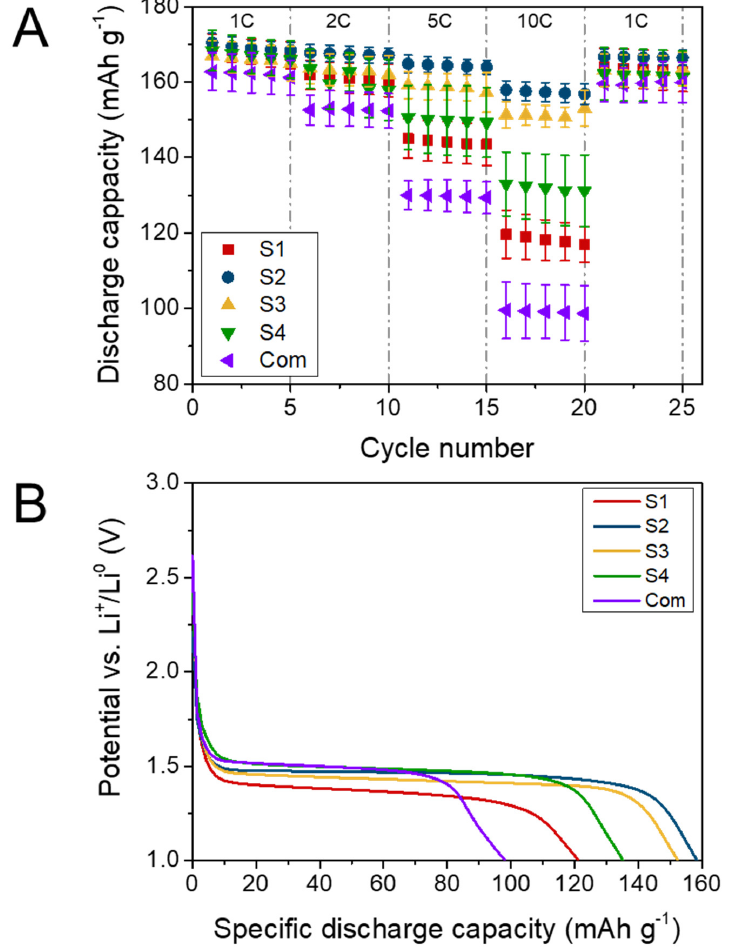
Figure 5. Chronopotentiometry results for sol–gel synthesized LTO and commercial sample: ( A ) rate capability and ( B ) discharge curves at 10 C current rate.